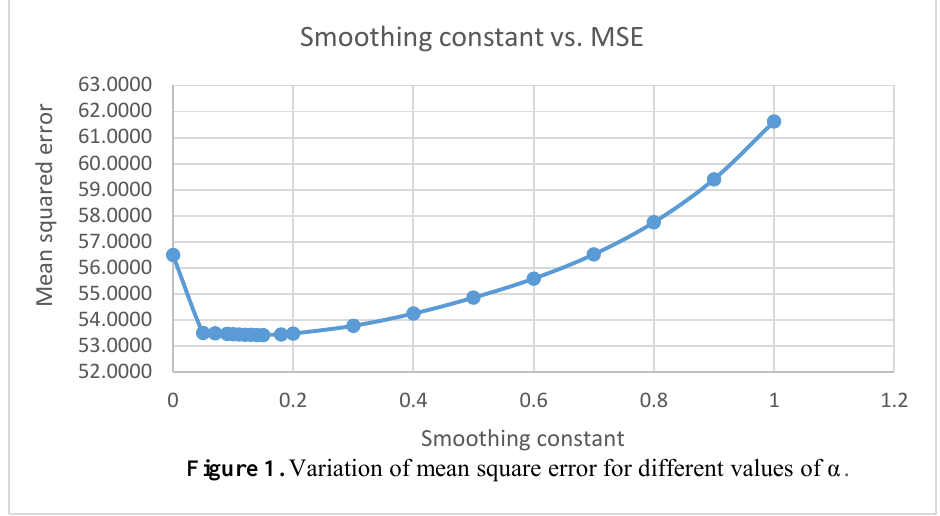
Smoothing constant vs. MSE